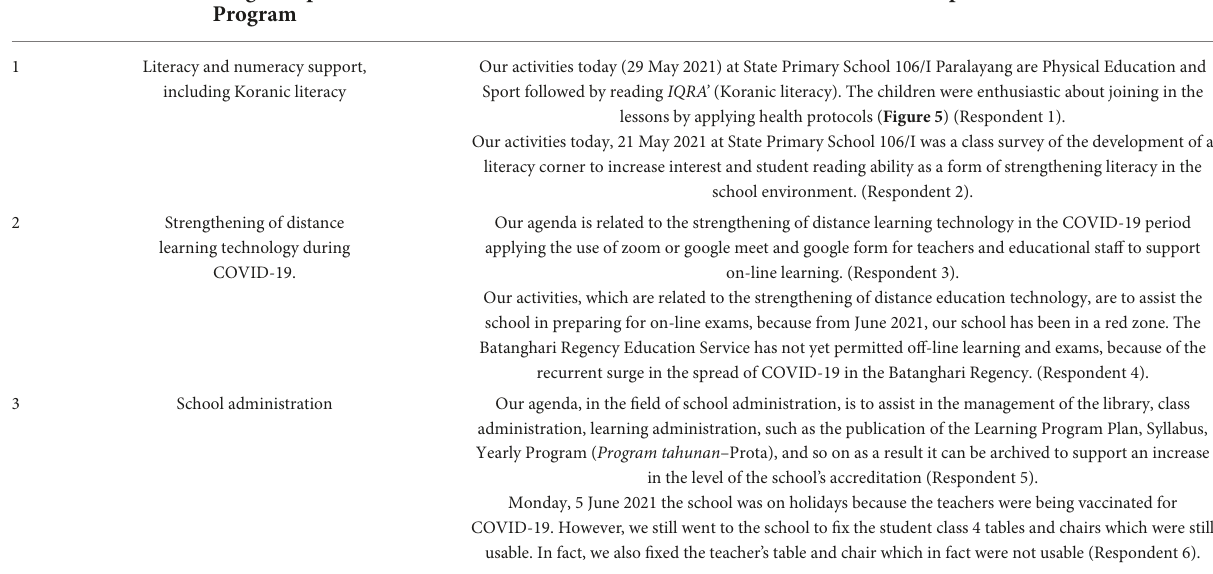
Results of the interview with respondents